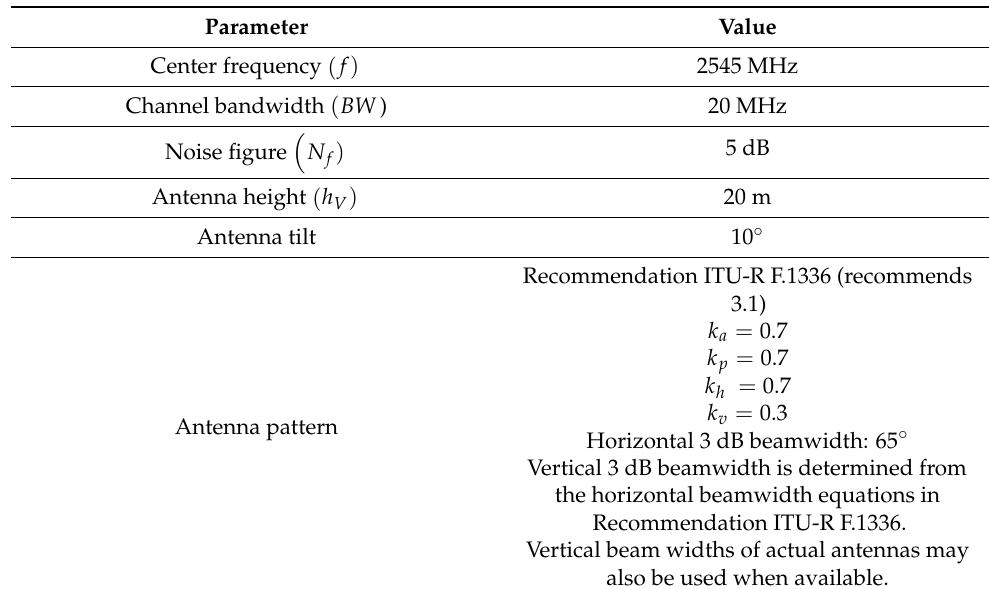
Table 2. Interfered system (IMT BS)